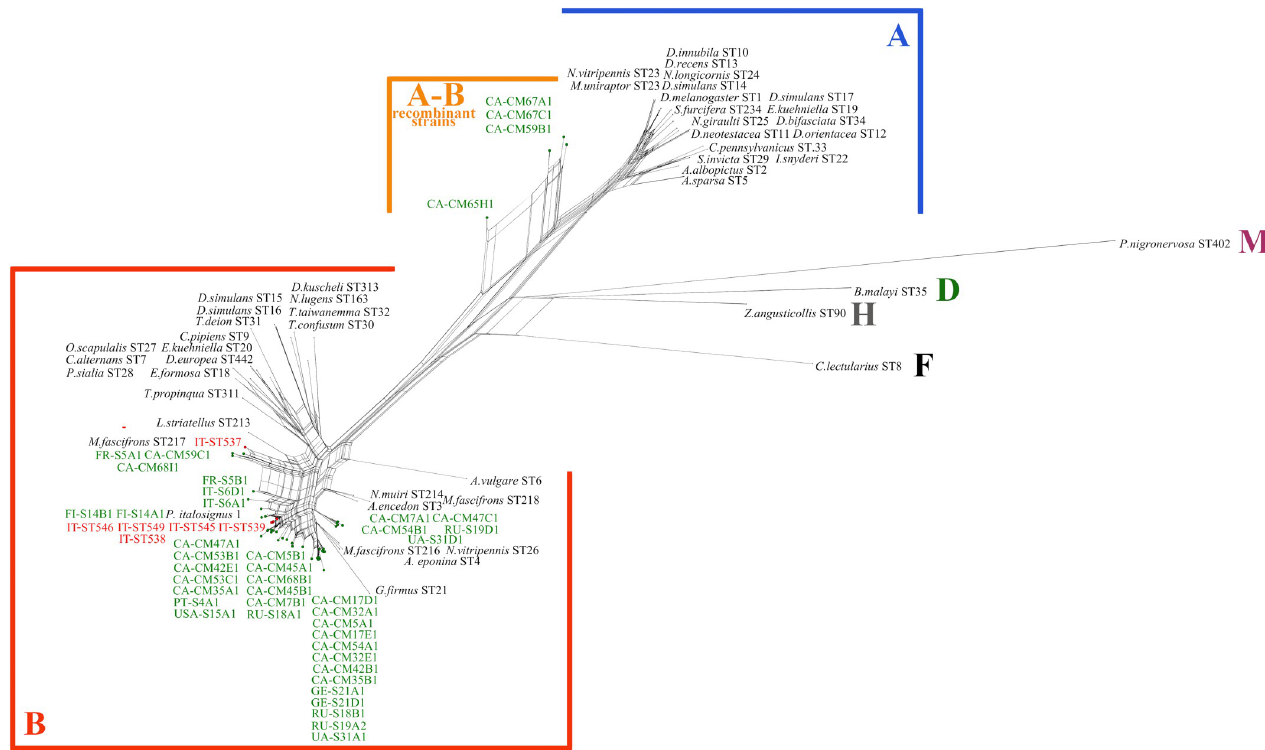
Fig 5. Neighbour-net phylogenetic network based on concatenated MLST gene sequences of Wolbachia . Wolbachia STs found in Philaenus spumarius and sequenced in this work are shown in red (IT means Italy). Wolbachia strains of P . spumarius by [53] are shown in green with the original strain number preceded by the acronym of the Country of origin. Reference Wolbachia STs were imported from the MLST database and are indicated on the tree with the name of the host species and the number of the ST. The capital letters indicates the Wolbachia supergroups.